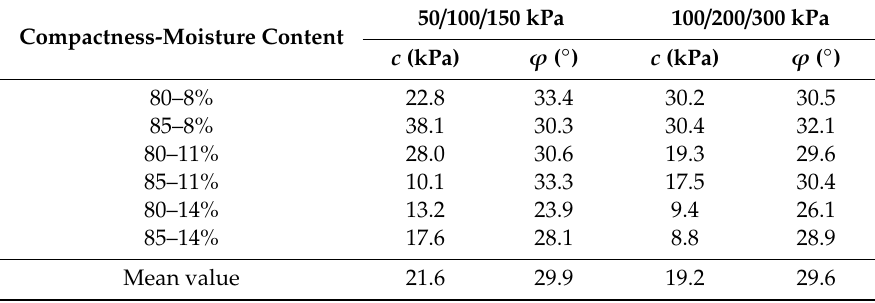
Table 3. Test results of unconsolidated-undrained triaxial